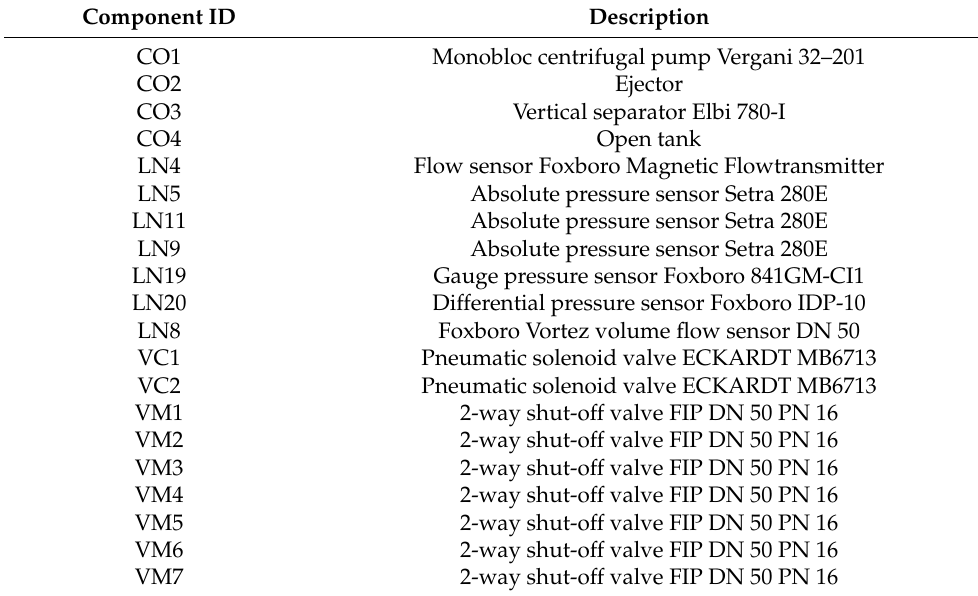
Table 1. Sensors and components equipped on the